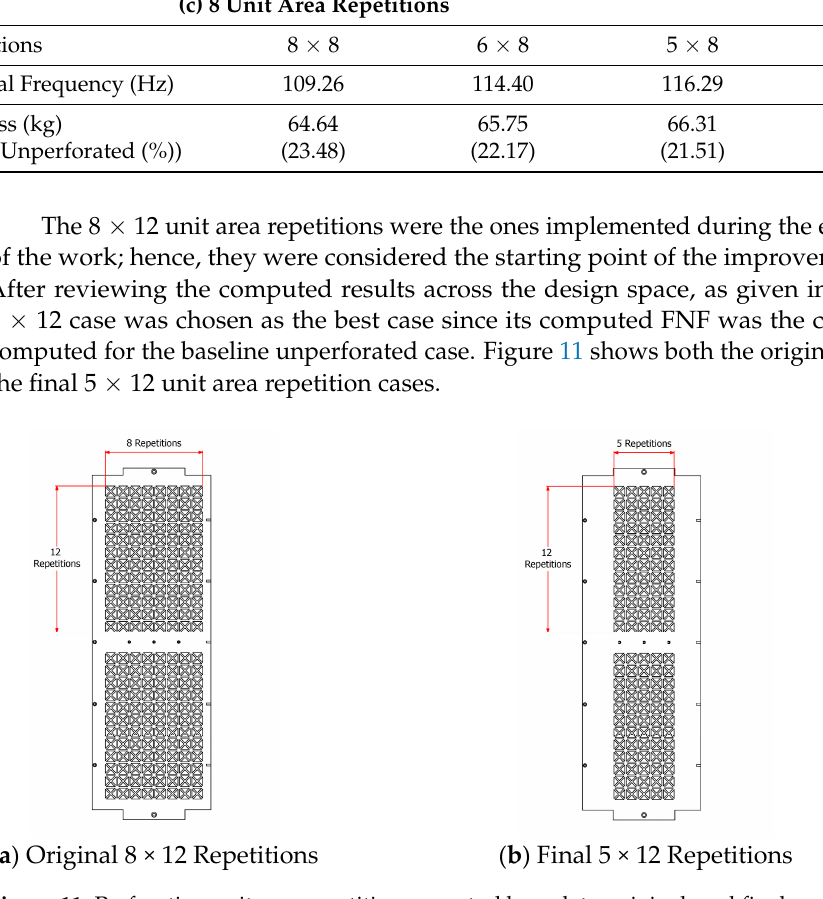
Figure 11. Perforation unit area repetitions—central box plate, original, and final.